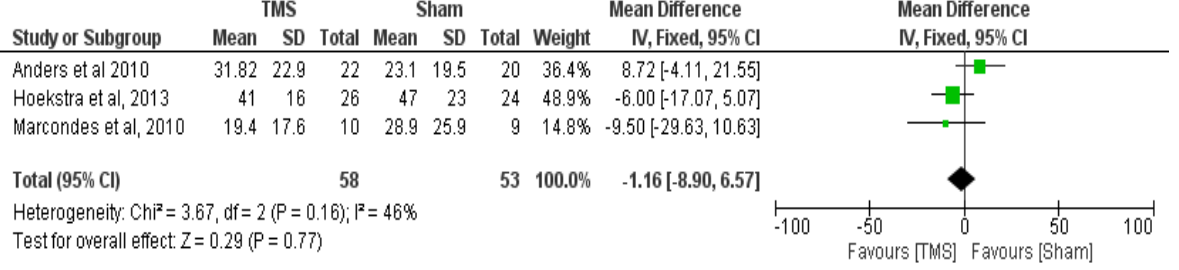
Figure 3. Forrest-plot showing the mean THI scores in rTMS versus Sham (6 months post-intervention) in the three